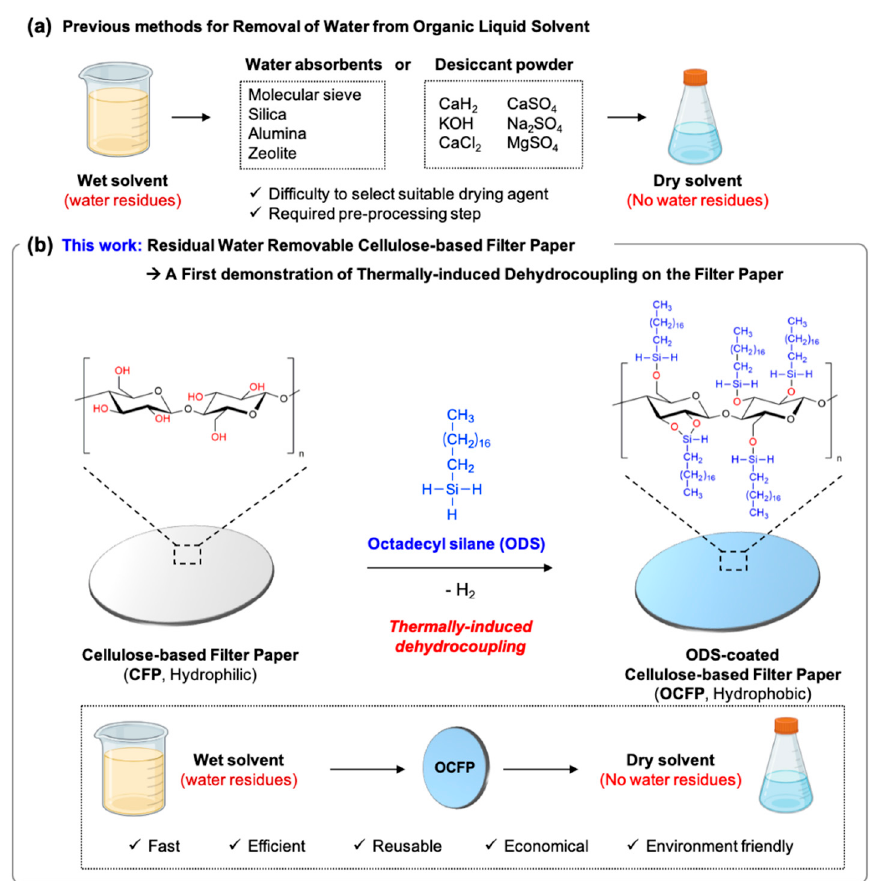
Figure 1. Schematic illustrations of the water removal methods for organic solvents. ( a ) General methods for water removal from organic solvents. (i) Water absorbents such as molecular sieve, silica, alumina, and zeolite. (ii) Desiccant powders such as calcium hydride (CaH 2 ), potassium hydroxide (KOH), calcium chloride (CaCl 2 ), calcium sulfate (CaSO 4 ), sodium sulfate (Na 2 SO 4 ), and magnesium sulfate (MgSO 4 ). ( b ) Current work: residual water removal cellulose-based filter paper (CFP). The surface of CFP was modified with octadecylsilane (ODS) via a thermally induced dehydrocoupling reaction between the trihydridosilane (Si–H 3 ) of ODS and hydrogen oxide (OH) of cellulose-based filter paper (CFP) under mild thermal conditions (80 °C), resulting in obtaining hydrophobic properties.